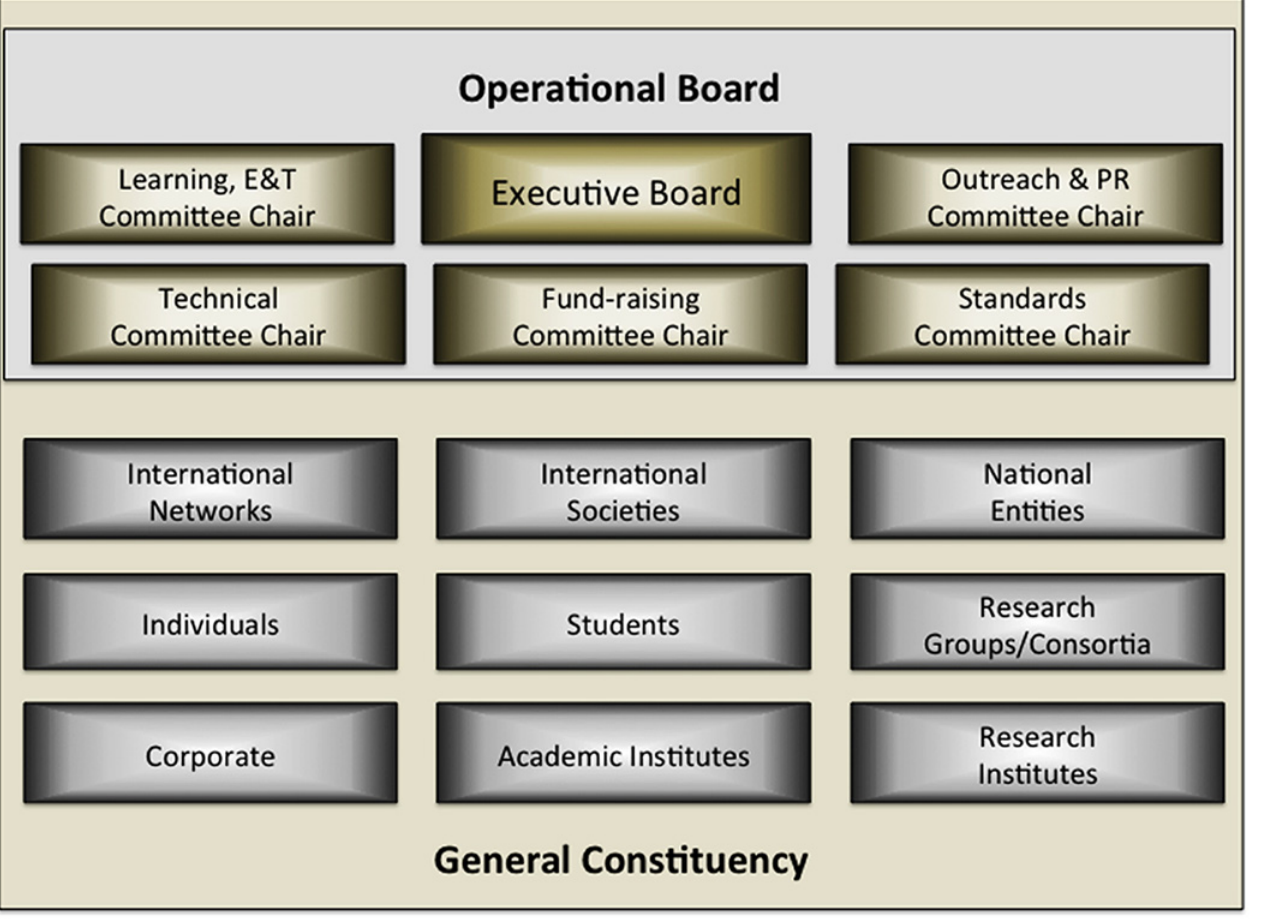
Fig 1. Governance structure. The operational board comprises the executive board and committee chairs. The general constituency includes representatives of member organisations, and individuals.